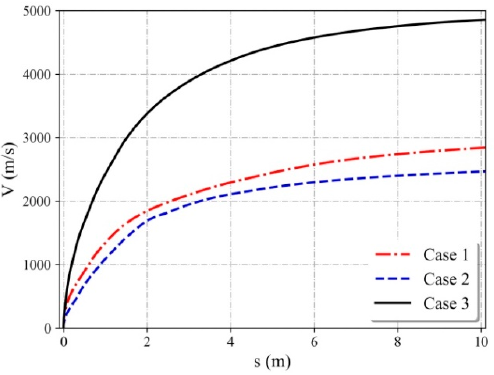
Figure 11. Simulated projectile velocity versus projectile travel distance. Appl. Sci. 2020 , 10 , x